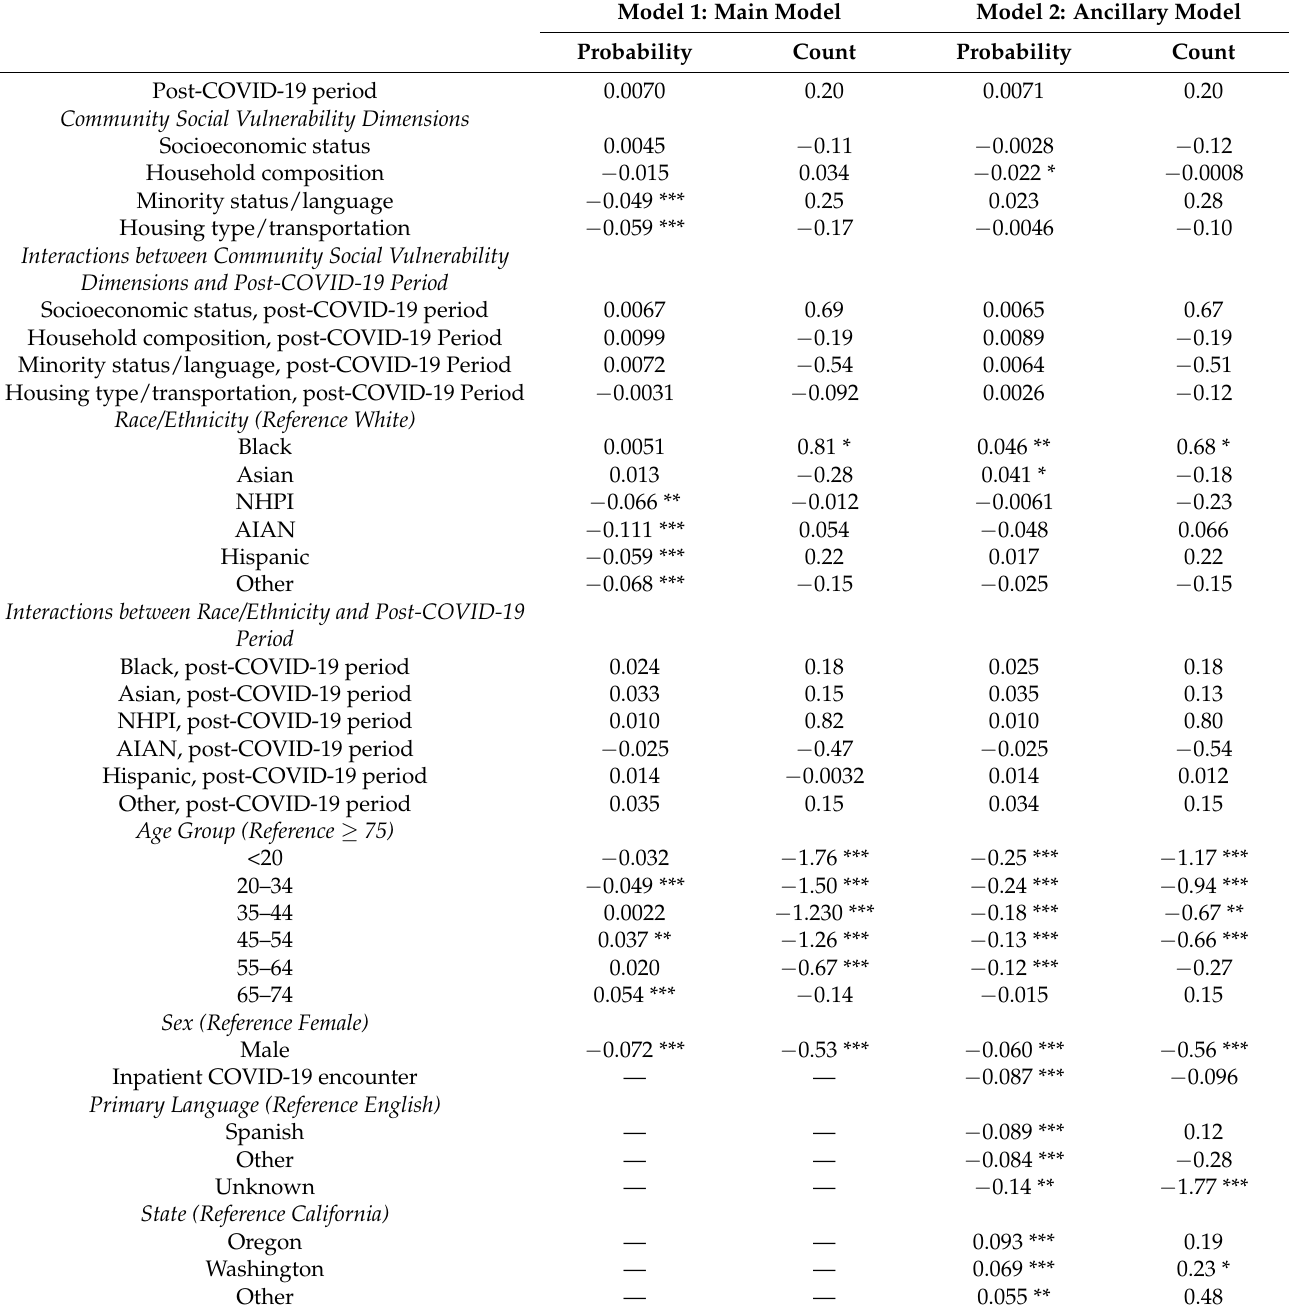
Table 3. Probability and count of PCP visit utilization among individuals diagnosed with COVID-19. Model 1: Main Model Model 2: Ancillary